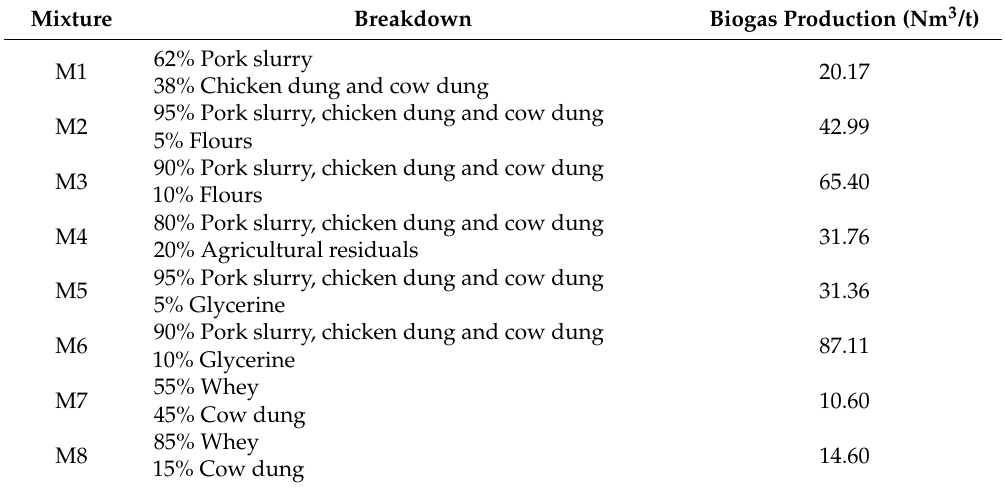
Table 5. Potential net production of biogas for each evaluated mixture (data from